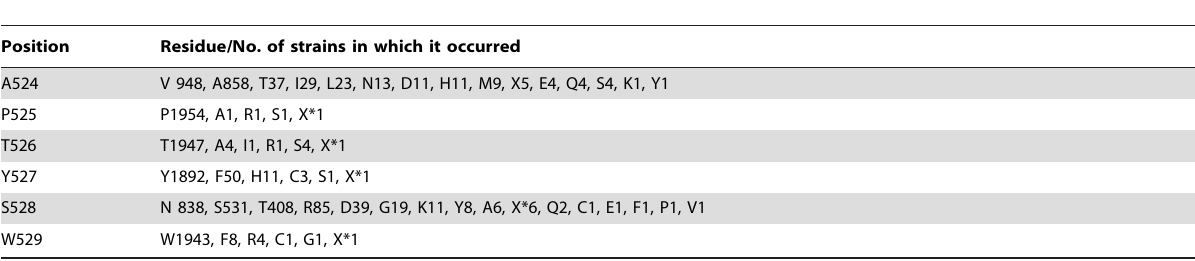
Table 1. Sequence conservation of amino acid residues 524–529 (n